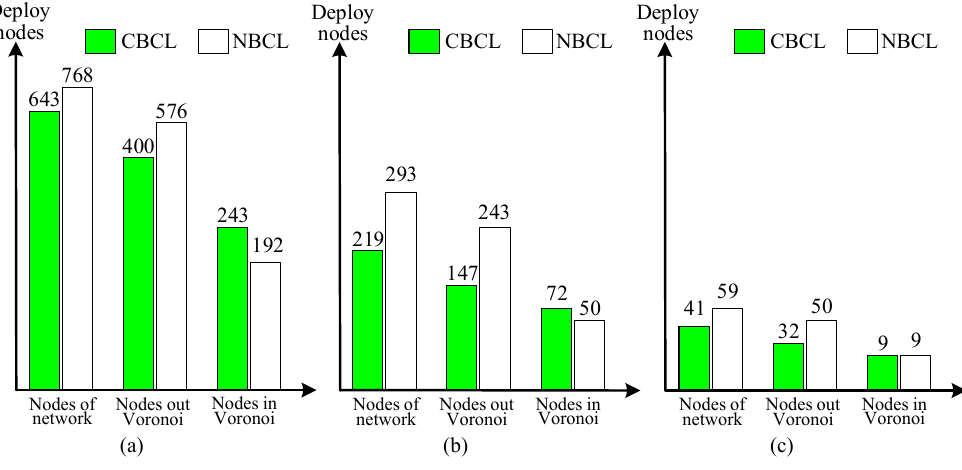
Figure 8. The nodes number on our approach and NBCL: ( a ) d b = 0.67; ( b ) d b = 1; ( c ) d b = 2.